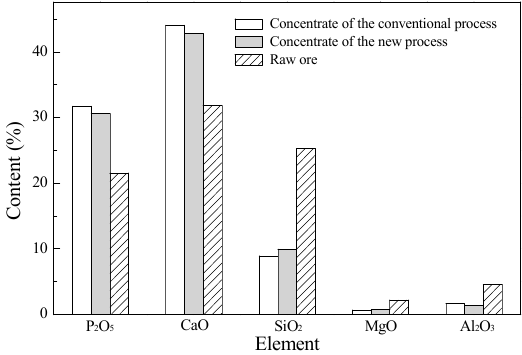
Figure 10. Chemical compositions of concentrates and raw ore.